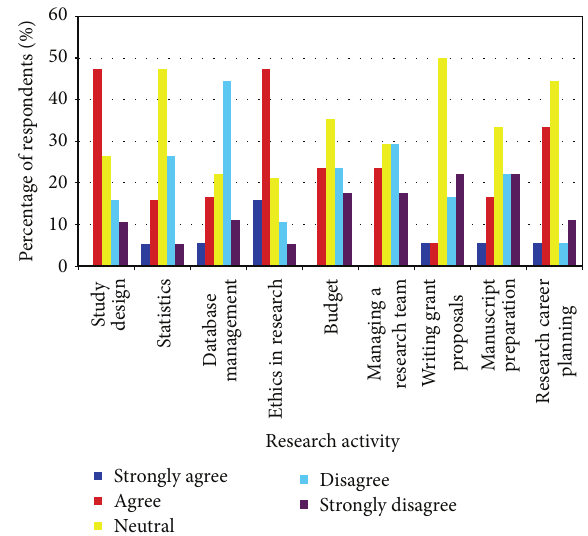
Figure 1: Response of critical care trainees to the question: “Formal